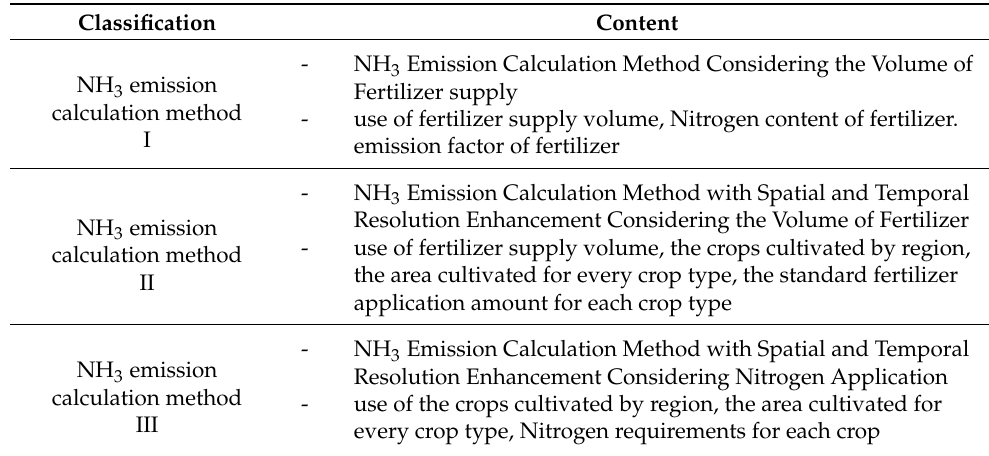
Table 2. Overview of methods for calculating NH 3 emissions in fertilized application sector.